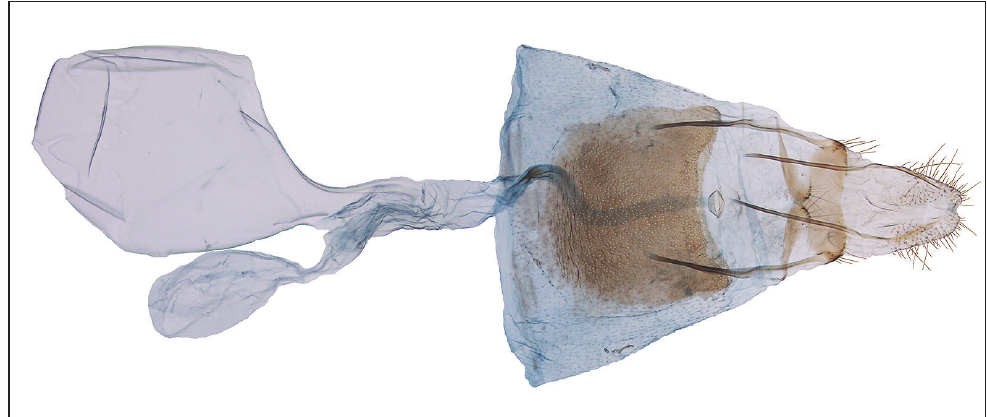
Figure 3. The female genitalia of Plutella polaris . (Photo: L.